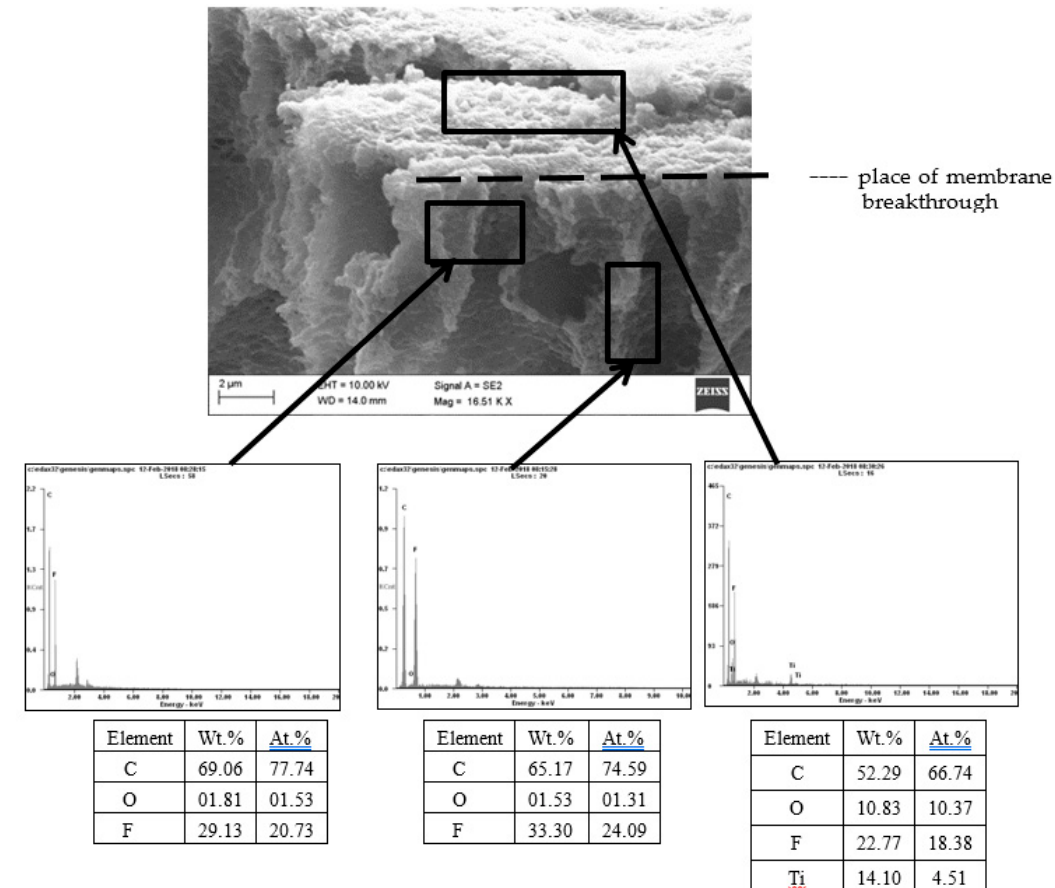
Figure 5. SEM photo of the membrane after the photocatalysis FA (P25) + UF process and elemental analysis of membrane material and sediment on the membrane.